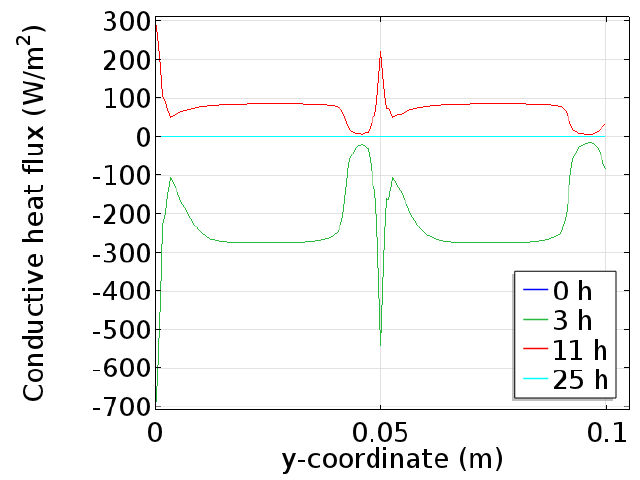
Figure 13. Internal distribution of temperatures predicted by the 2D model at two instances in the trial: 3 h after the start time, when the PCM is solidifying; and 11 h after the start when the PCM is melting.